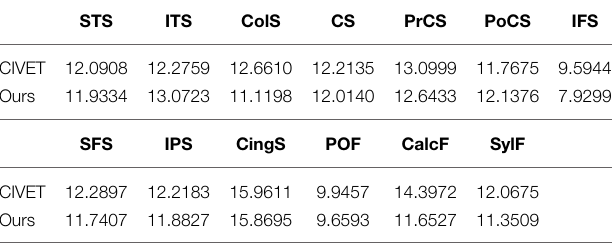
TABLE 2 | Variances of cortical properties for different correspondence methods (unit: mm ).